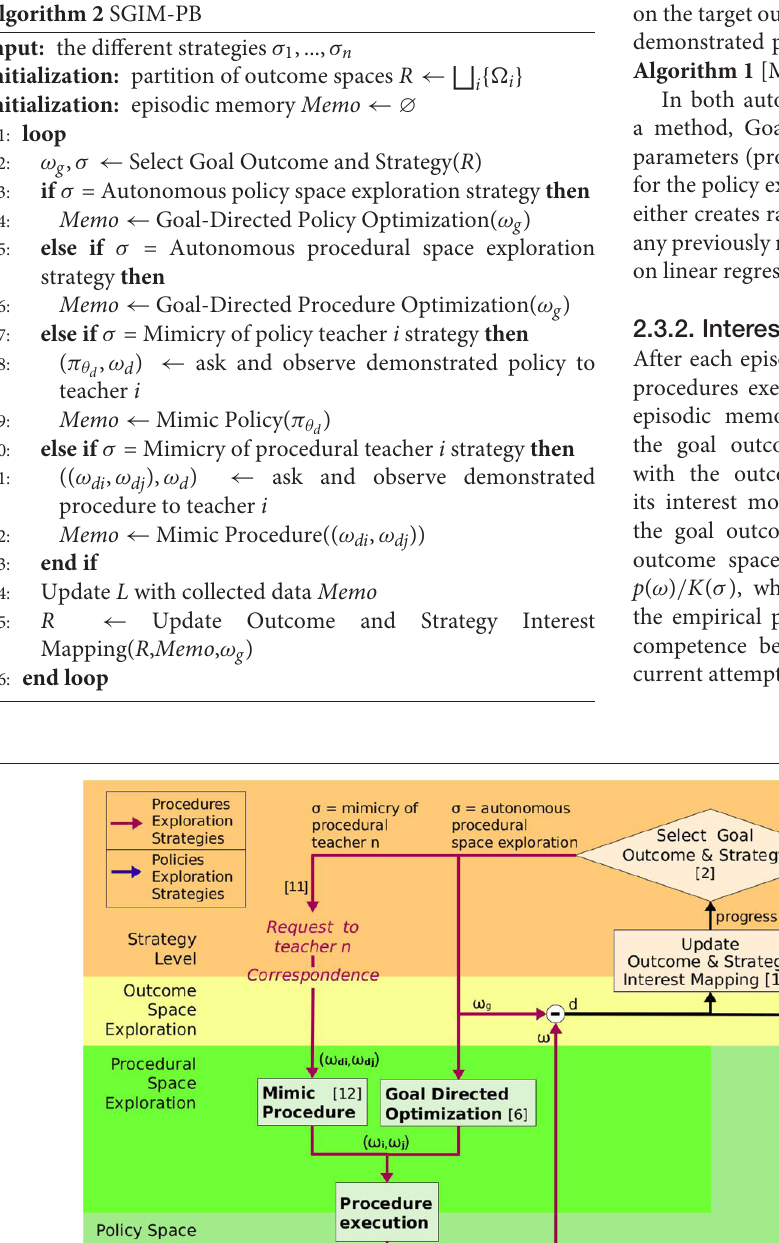
Frontiers in Neurorobotics |